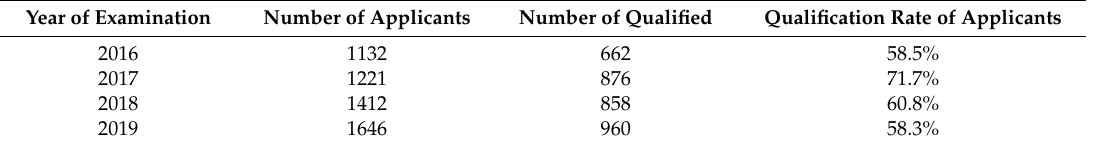
Figure 1. Numbers of applicants for the examination of general manual welding technicians from 2016 to 2019. Table 1. Statistics for the qualification of the general manual welding examination.